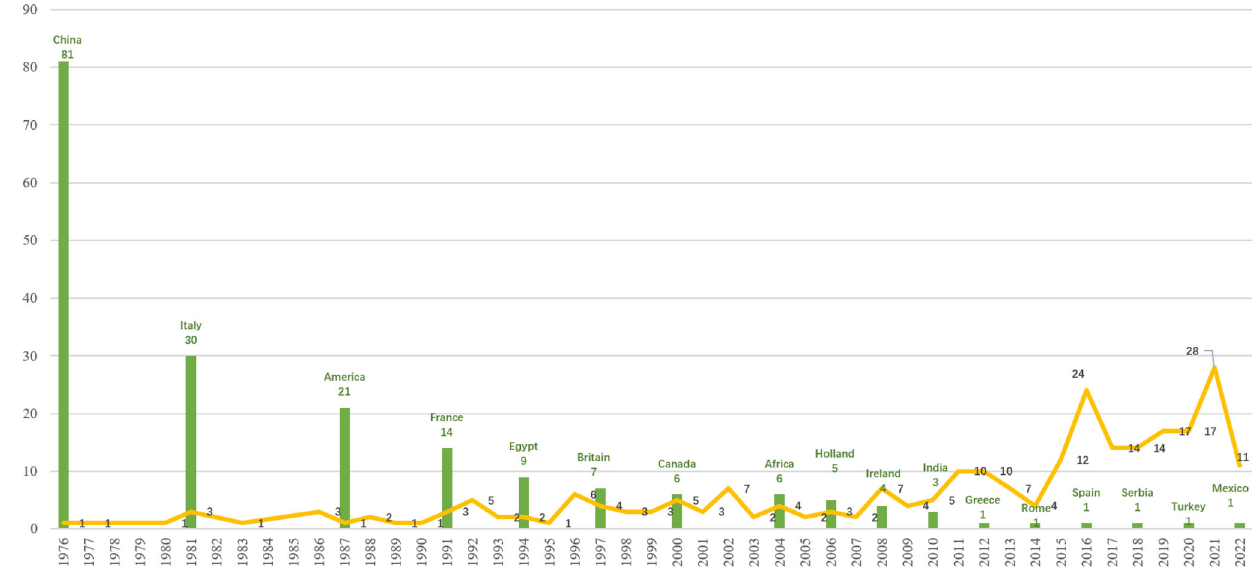
Fig. 1 Annual quantity of grand canal literatures published in WoS database (1976 – 2022).